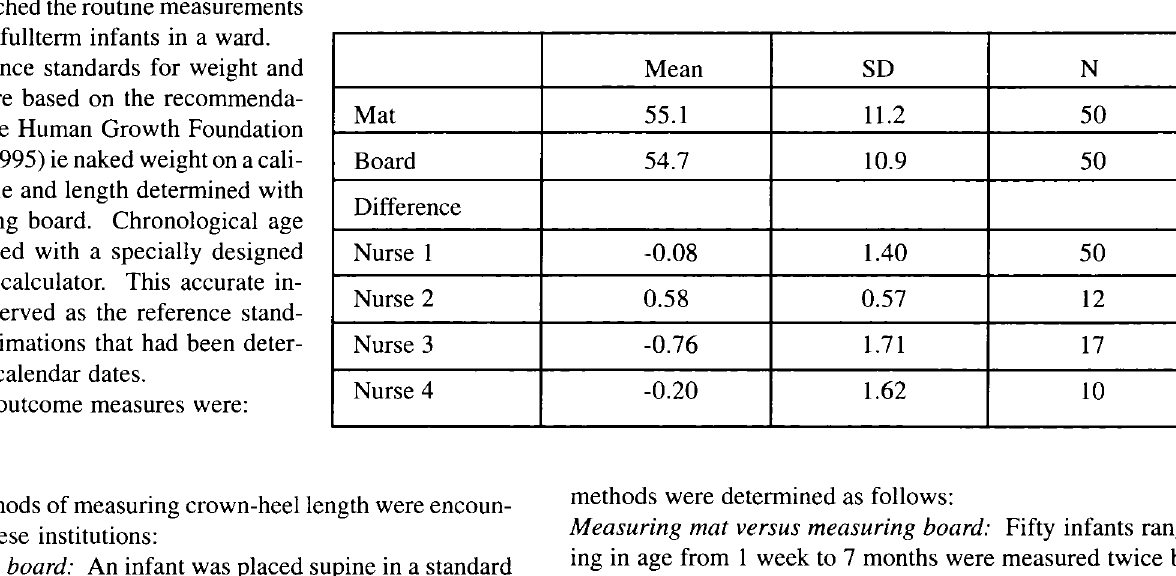
Table 1 . Measurements in centimetres made with M at and Board